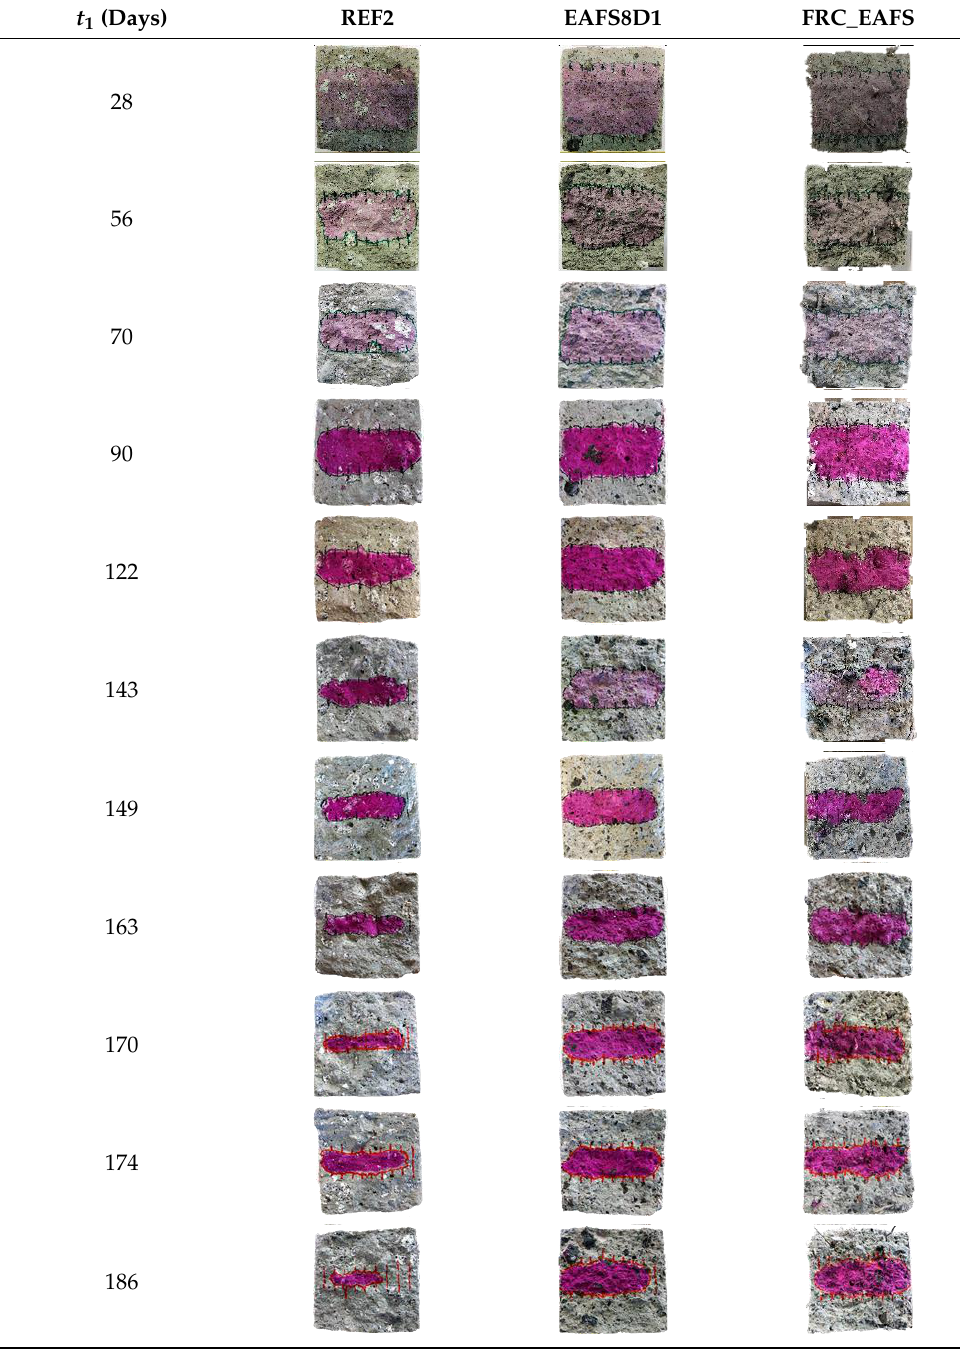
Table 18. Evolution of carbonation depth at increasing exposure times for the REF2 mixture and for the mixtures designed with EAFS and RTSF.